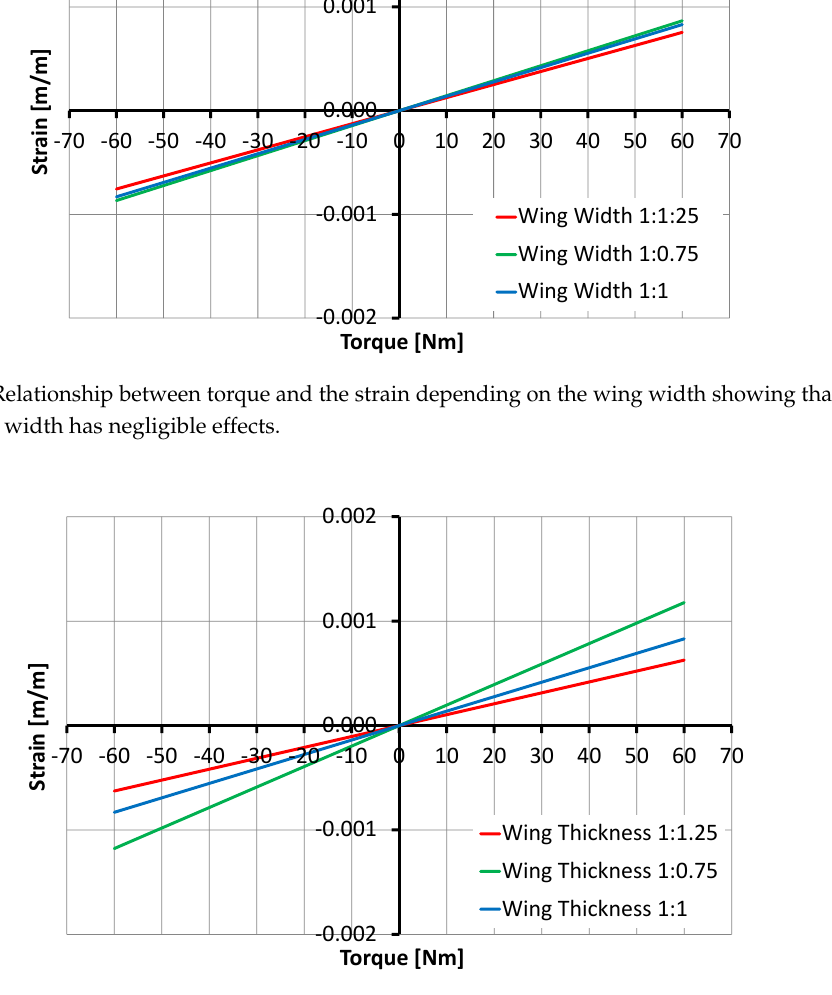
Figure 14. Relationship between the torque and the strain depending on the wing thickness parameter: the 25% of variation influences torque sensor behavior. The reduction increases more than 40% the strain and the increment of the thickness reduces it by 25%. This means that the width reduction has more influence than the width